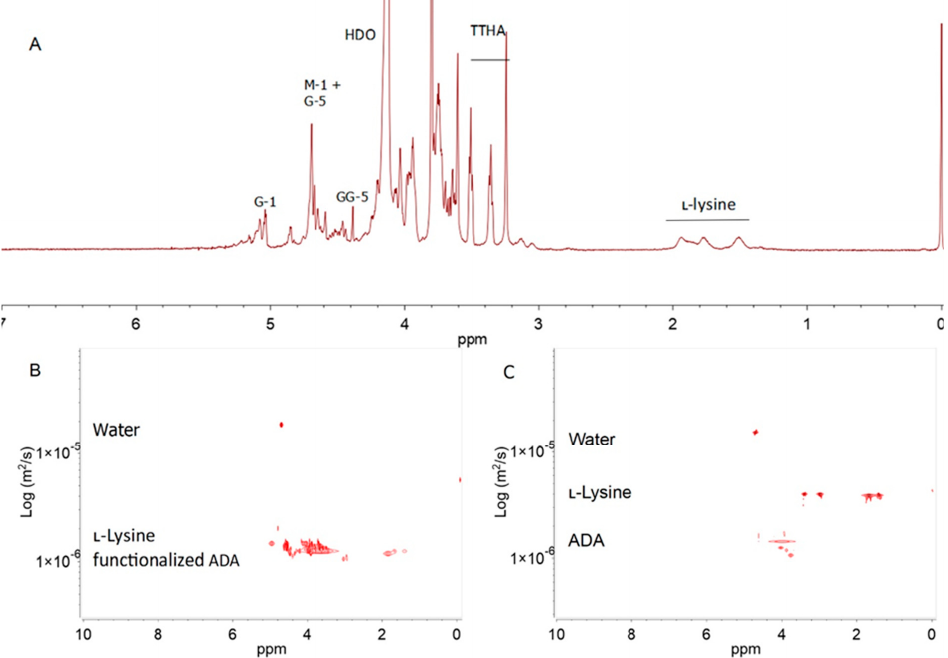
Figure 3. The 1 H NMR spectrum (500 MHz, 90 °C) of ʟ -lysine − functionalized ADA in D 2 O with the identification of the main signals. The spectral annotation of the alginate residue is given according to Grasdalen et al. [5] ( A ). The DOSY spectra of a mixture of non − covalently bound ADA and ʟ -lysine ( B ) and ʟ -lysine-functionalized ADA ( C ) in D 2 O recorded at 25 °C. NMR DOSY was employed to verify the covalent bonding between ADA and ʟ -lysine (Figure 3B). The diffusion coefficient of the covalent bond of ʟ -lysine − functionalized ADA appeared in the same region. For comparison, the physical mixture of ADA and ʟ -lysine, which was stirred for 24 h without the reduction agent, was diluted in D 2 O before measuring the DOSY spectrum (Figure 3C). This mixture signal showed the difference between the ADA and ʟ -lysine diffusion coefficients. The DOSY spectrum difference between the covalent bonding and physical mixture of ADA and ʟ -lysine indicated that the coupling was successful.